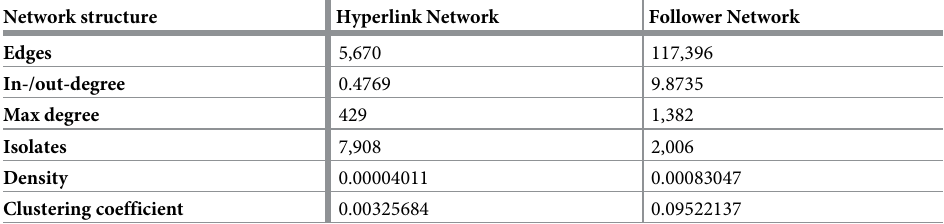
Table 2. Structural differences between the Hyperlink and Follower